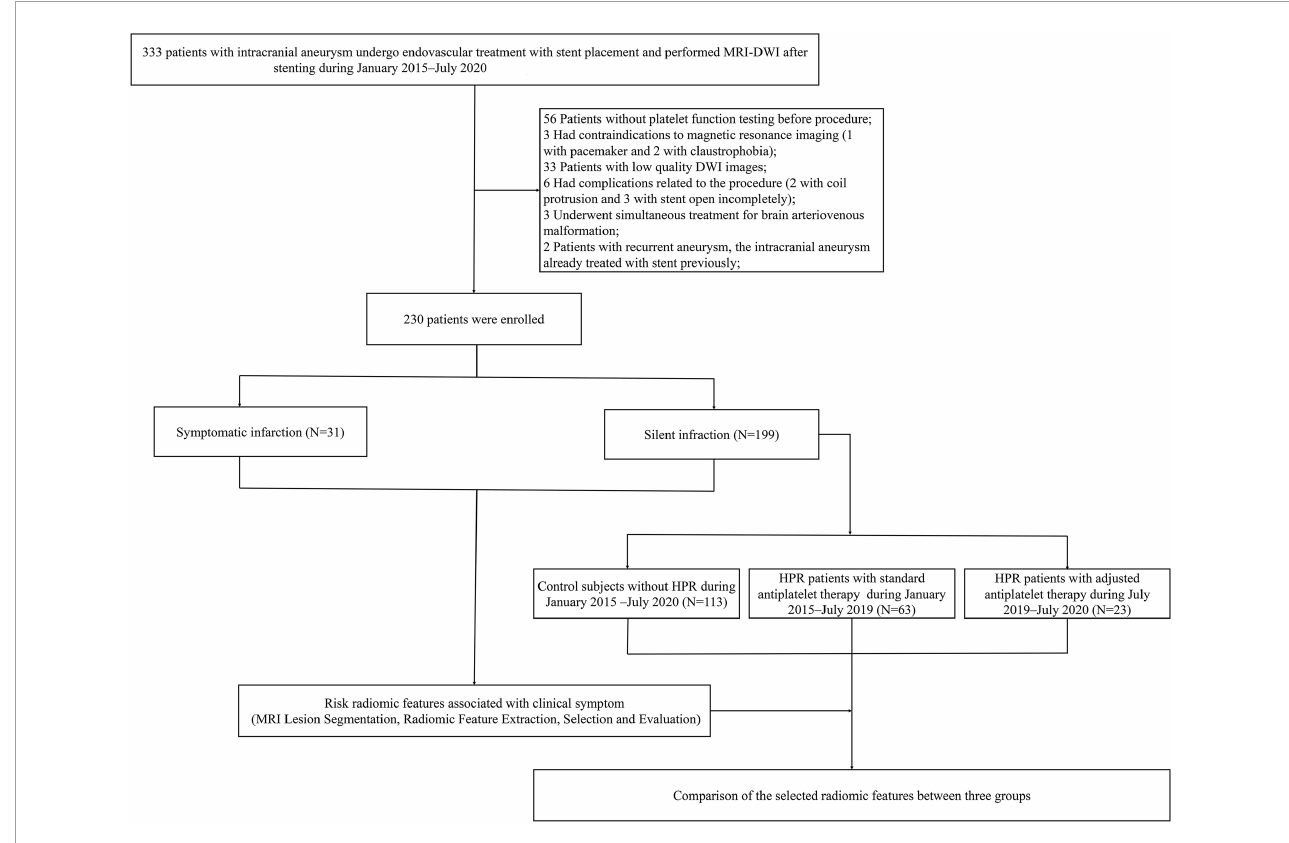
FIGURE1 Flowchart of patient